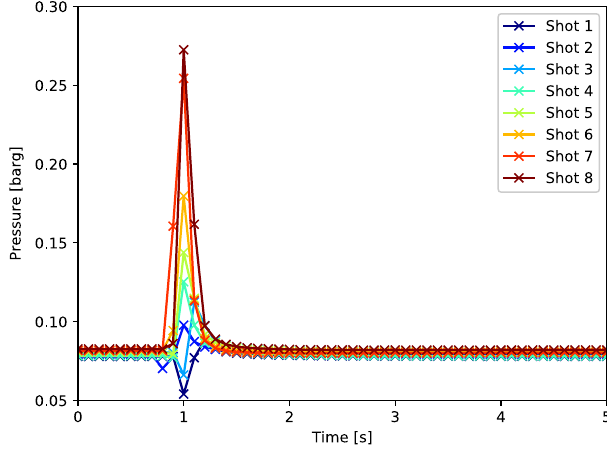
FIG. 22. Pressure measurements acquired during the eight shots, superimposed over each other and synchronized in